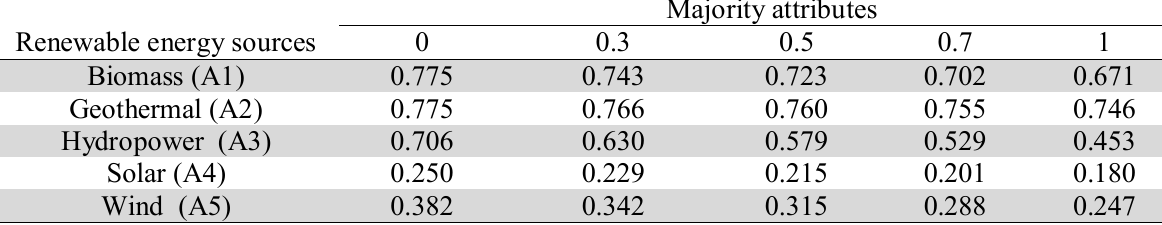
Values effects of the majority attributes for the ranking of renewable energy sources